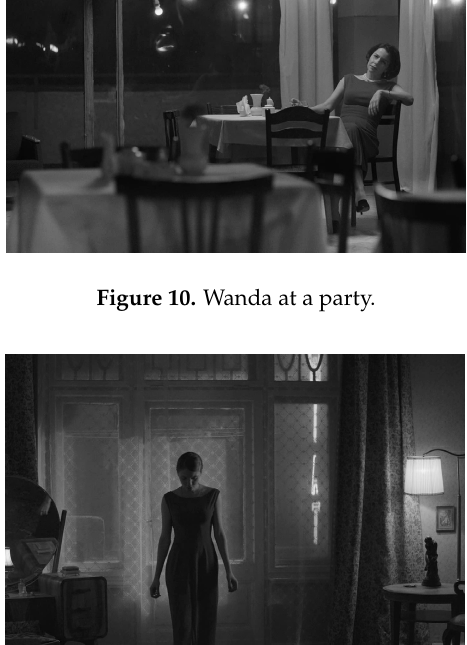
Figure 10. Wanda at a party. Figure 11. Ida in her Aunt’s dress. Figure 11. Ida in her Aunt’s